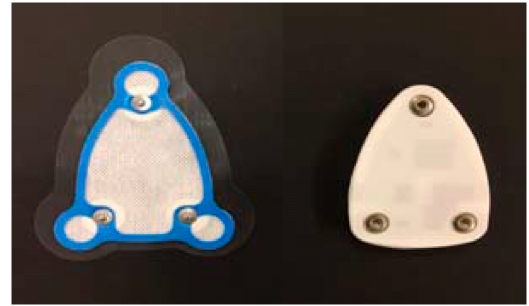
Figure 15. The adhesive coating between sensor and chest.